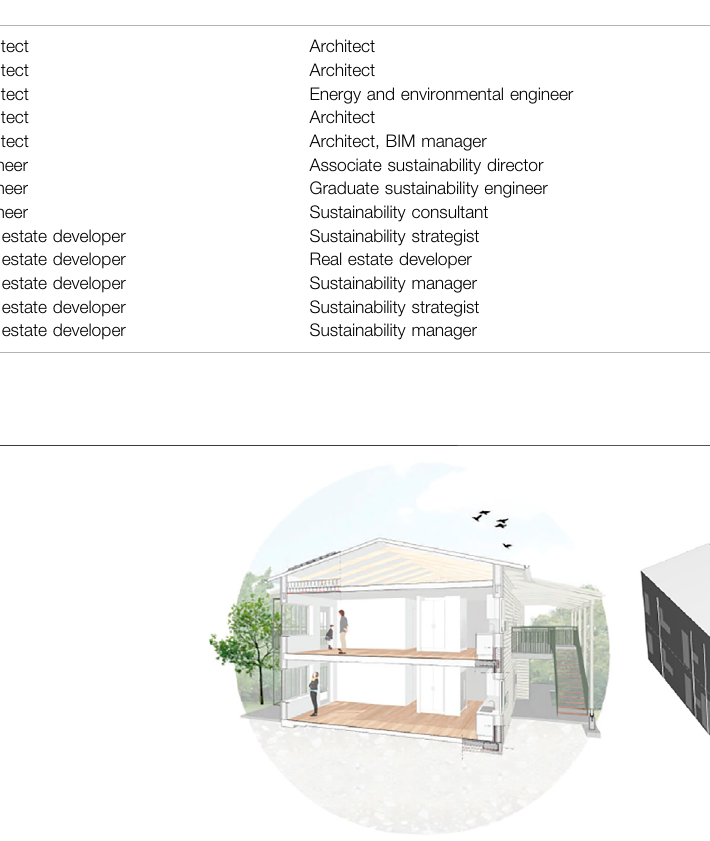
TABLE 1 | Interviewees participating in the study. Company category